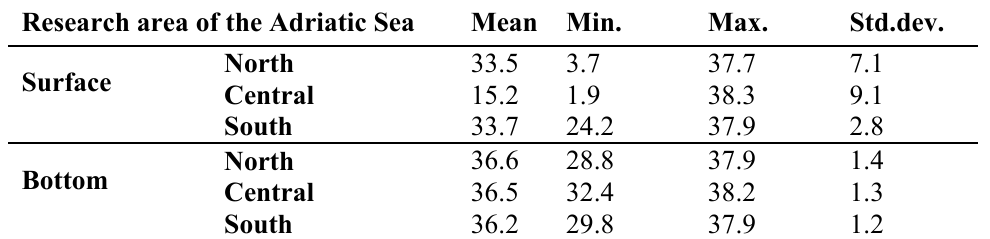
Table 2. Surface and bottom salinity at the investigated stations for 2006 – 2008 period. Research area of the Adriatic Sea Mean Min. Max.